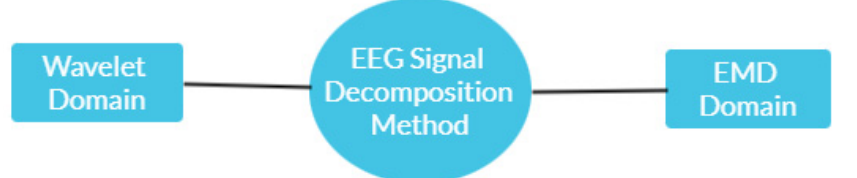
Figure 3. Seizure decomposition method.